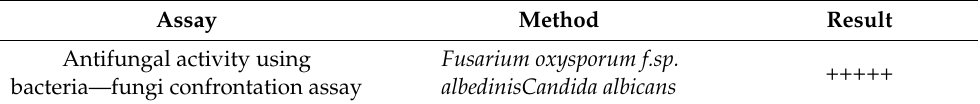
Table 2. Cont. Assay Method